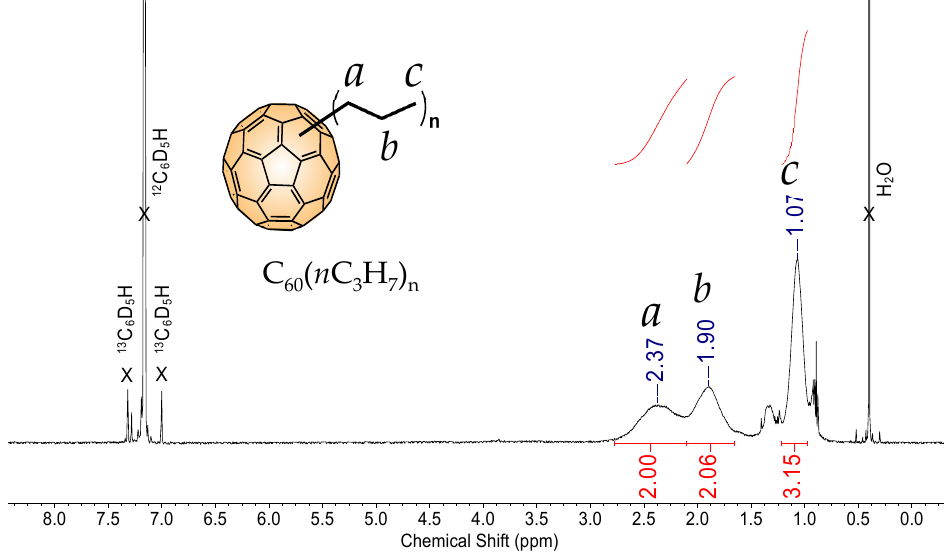
0.00.51.01.52.02.53.03.54.04.55.05.56.06.57.07.58.0 Chemical Shift (ppm) Figure 3. 1 H NMR (500 MHz, C 6 D 6 ) spectrum of the obtained mixture of C 60 ( n C 3 H 7 ) n .